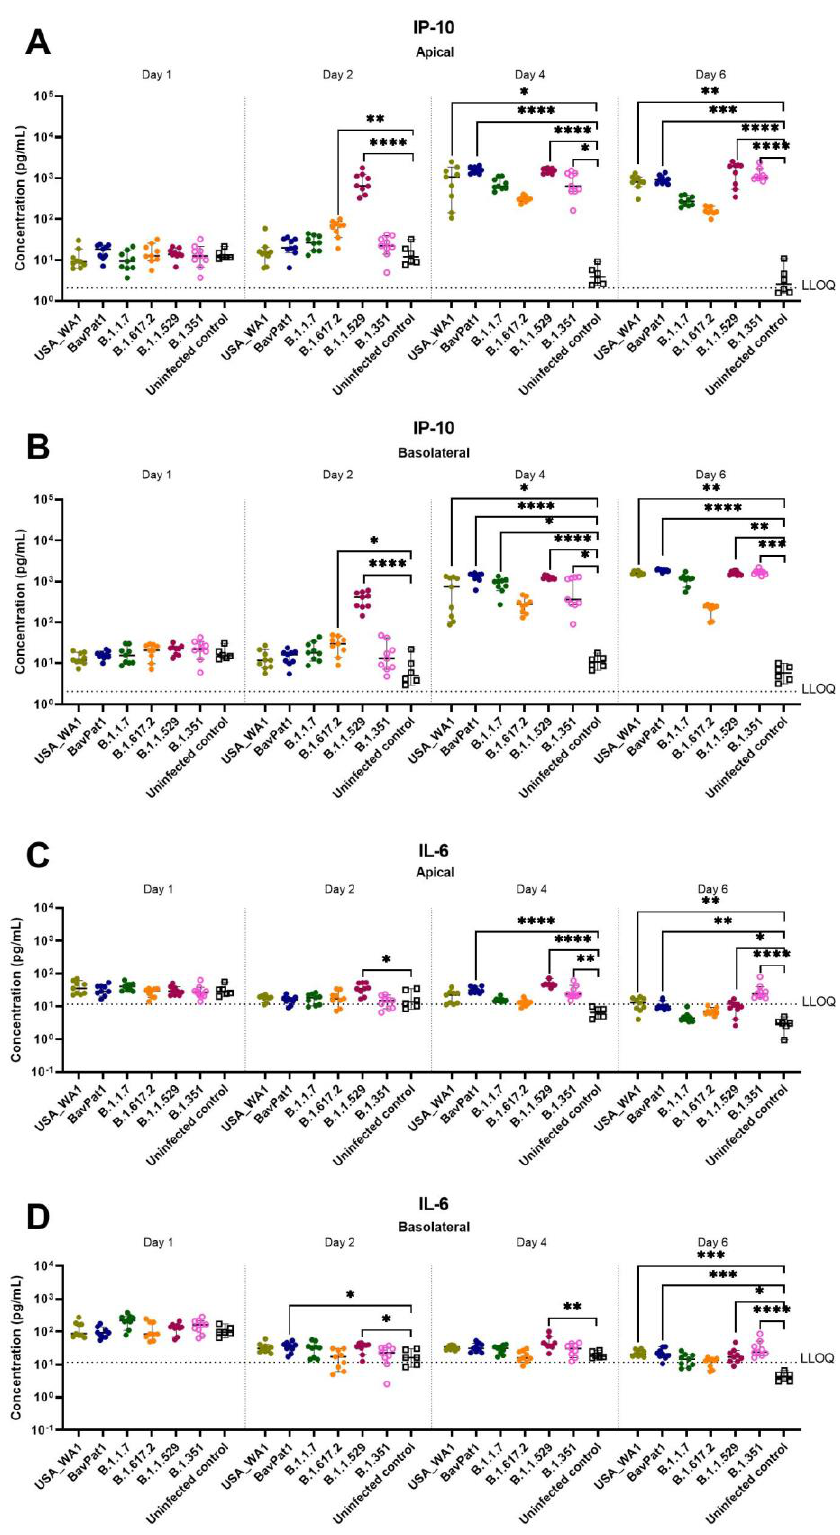
Figure 6. The expression of COVID-19-related chemokine and cytokine in HnAEC. Concentrations of IP-10 ( A , B ) and IL-6 ( C , D ) in the presence or absence of SARS-CoV-2 are expressed as pg per mL. Mean values with 95% CI are shown and statistical significance between the variants and non-infected control was calculated by Kruskal–Wallis with two-sided Dunn’s post hoc test. * p < 0.05, ** p < 0.01, *** p < 0.001, **** p <